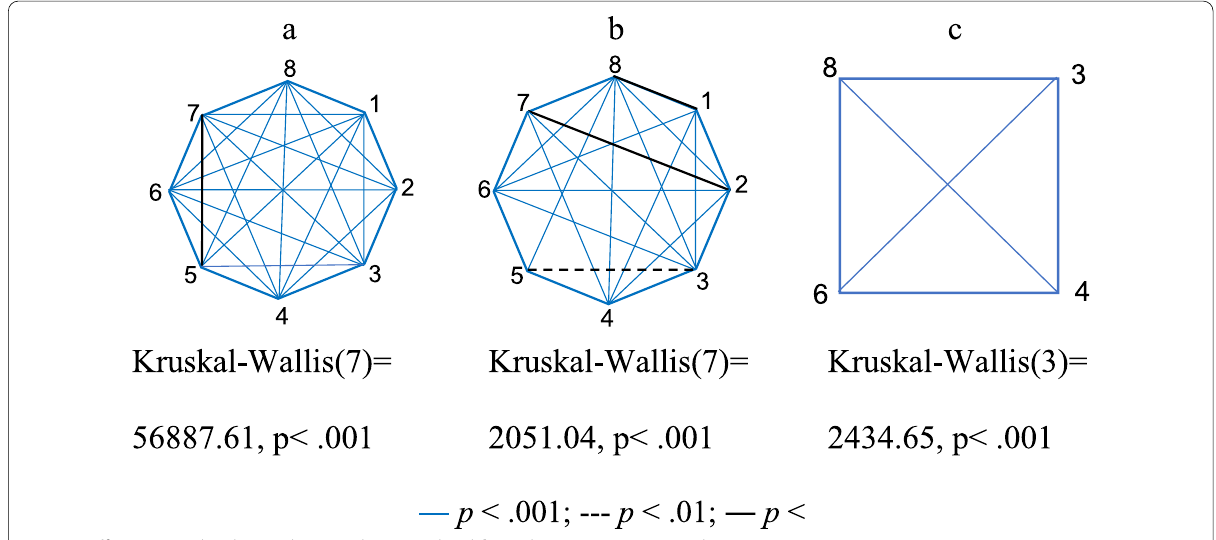
Fig. 6 Differences in distribution by a mathematics level, b mathematics success, and c science major